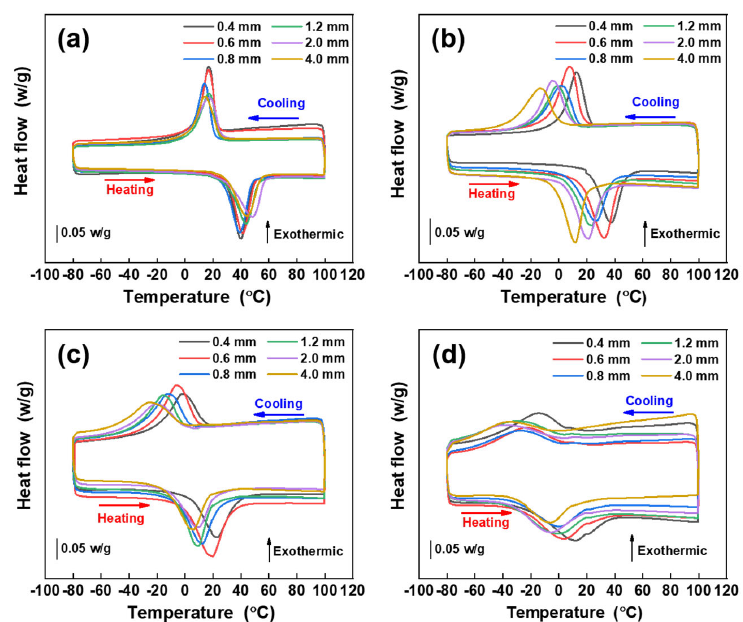
Figure 5. The DSC curves of SLM ‐ NiTi thin ‐ wall structures fabricated with different laser scanning speeds: ( a ) 400 mm/s, ( b ) 600 mm/s, ( c ) 800 mm/s, and ( d ) 1000 mm/s.